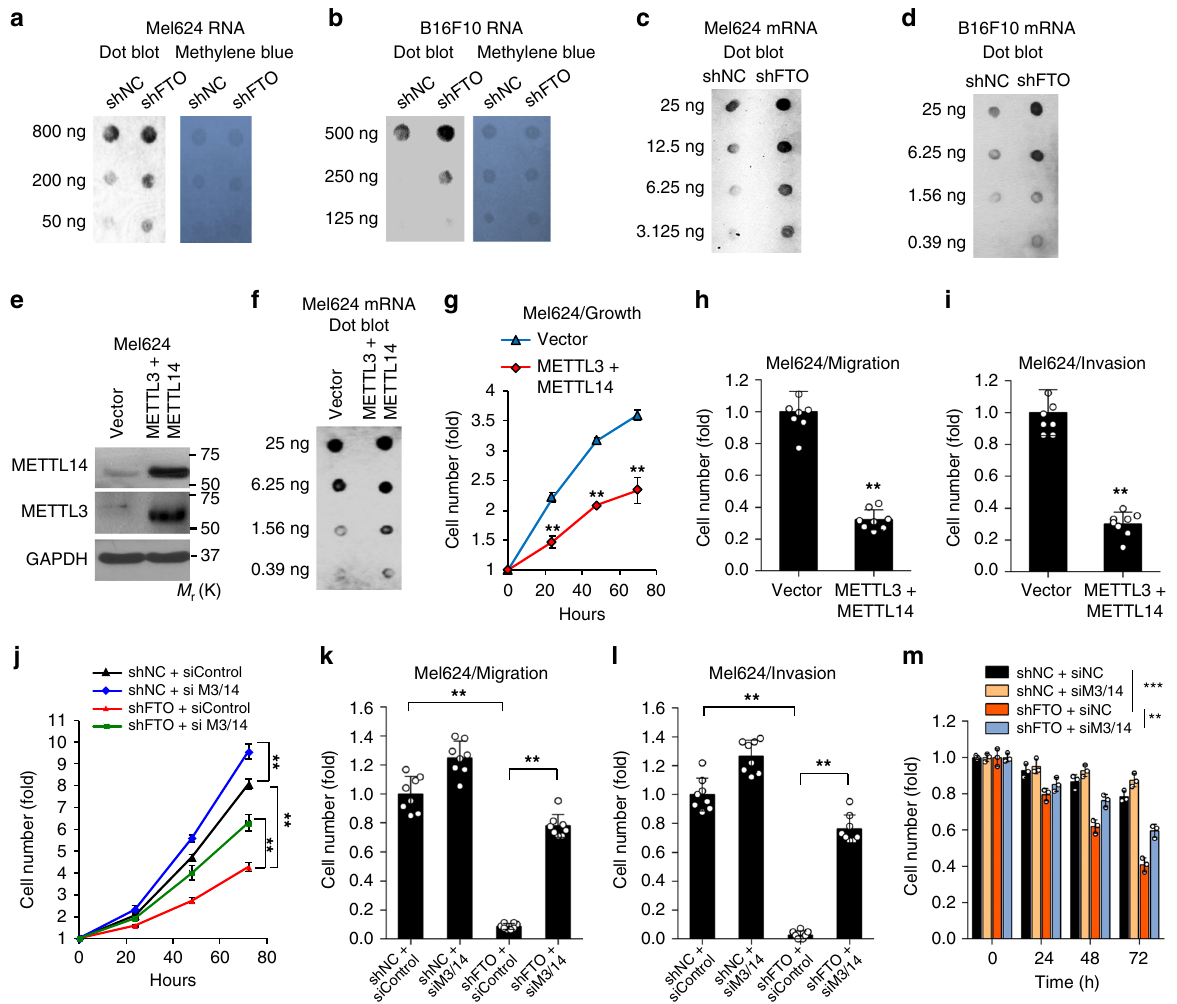
Fig. 3 m 6 A enrichment in mRNA, and the function of m 6 A in melanoma cells. a , b m 6 A dot blot assays using total RNA of Mel624 and B16F10 cells with or without FTO knockdown. Methylene blue staining was used as a loading control. c , d m 6 A dot blot assays using poly(A) + mRNA of Mel624 and B16F10 cells with or without FTO knockdown. e Immunoblot analysis con fi rming forced overexpression of METTL3 and METTL14 in Mel624 cells. f m 6 A dot blot assays using poly(A) + mRNA in Mel624 with or without forced overexpression of METTL3 and METTL14. g Cell proliferation assay in Mel624 cells with or without forced overexpression of METTL3 and METTL14. h Cell migration assay in cells in G. i Cell invasion assay in cells in g . j – m Cell proliferation ( j ), migration ( k ), invasion ( l ), and cell viability ( m ) assays in suspension in shNC and shFTO of Mel624 with or without knockdown of METTL3 (M3)